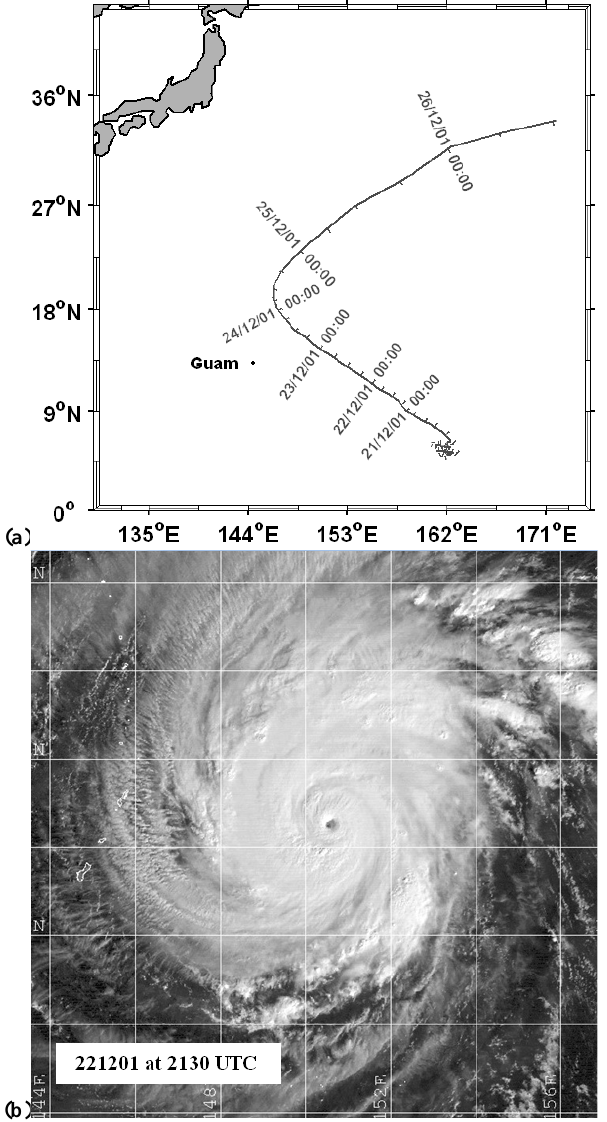
Fig. 2. (a) Best track of TC Faxai from 14 to 26 December 2001 and (b) GMS-5 Vis satellite image of TC Faxai near its peak intensity on 22 December at 21:30UTC. (Naval Research